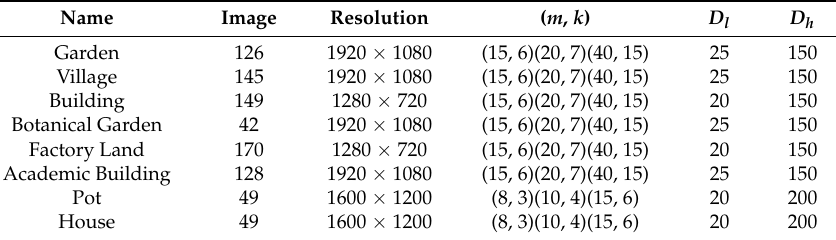
Figure 6. Images for experiment ( a ) Garden; ( b ) Village; ( c ) Building; ( d ) Botanical Garden; ( e ) Factory land; ( f ) Academic building; ( g ) Pot; and ( h ) House. Table 1. Information for the Experimental Image Data.